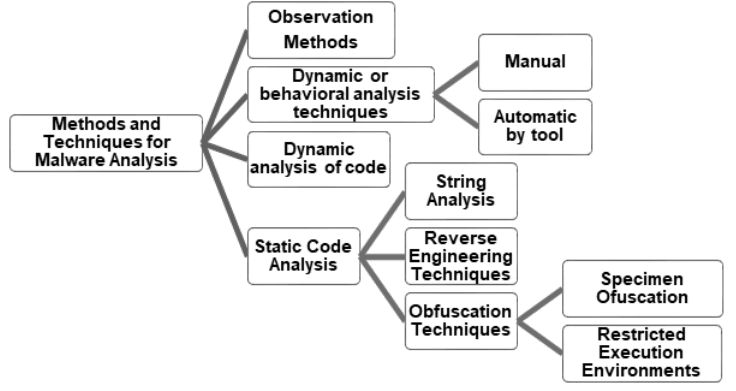
Figure 1. Methods and techniques for malware analysis.